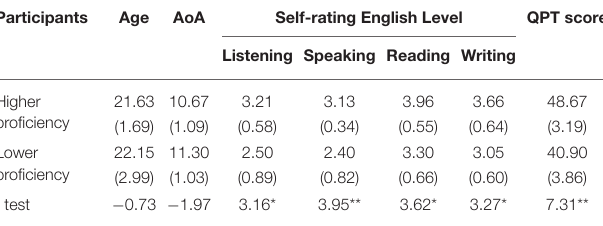
TABLE 2 | Background information of participants by proficiency level: Mean ( SD